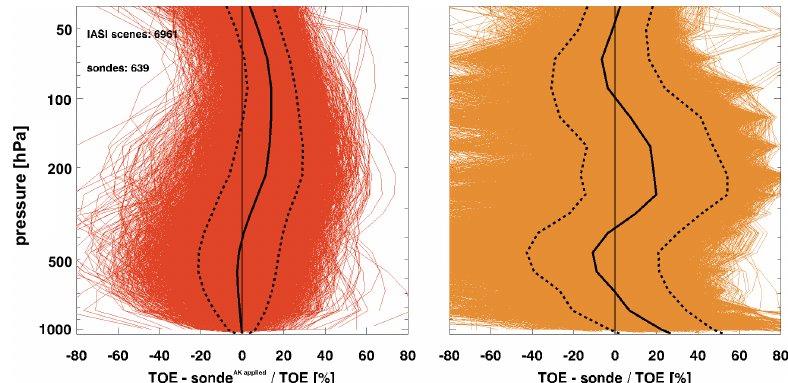
Figure 6. Bias of the IASI-TOE profiles with respect to the ozone sonde profiles. The number of profiles included are indicated in the legend. The left panel shows the comparison after the averaging kernels (AK) and a priori profiles have been applied to the ozone sonde profiles (see Eq. 8). The right panel shows the comparison without the averaging kernels applied. The coloured lines indicate the individual biases, the black solid lines the mean, and the dashed lines the 1 σ standard deviations of the averaging.